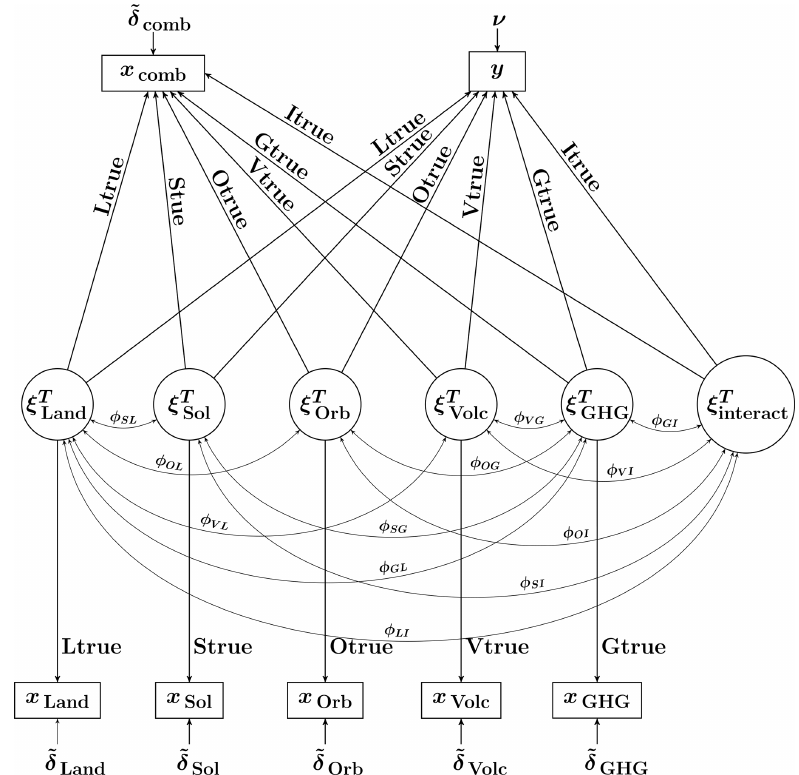
Figure 1. Path diagram of the CFA model from Table